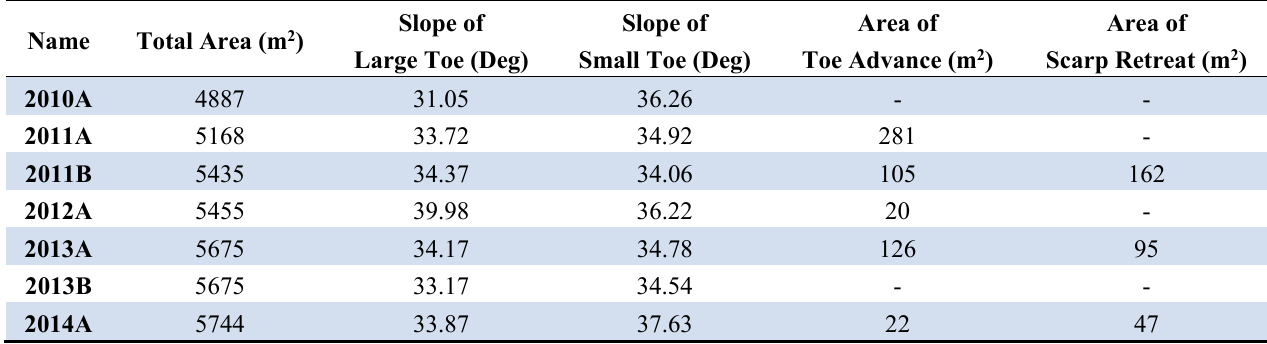
Table 4. Changes in area and leading edge slope of Home Hill